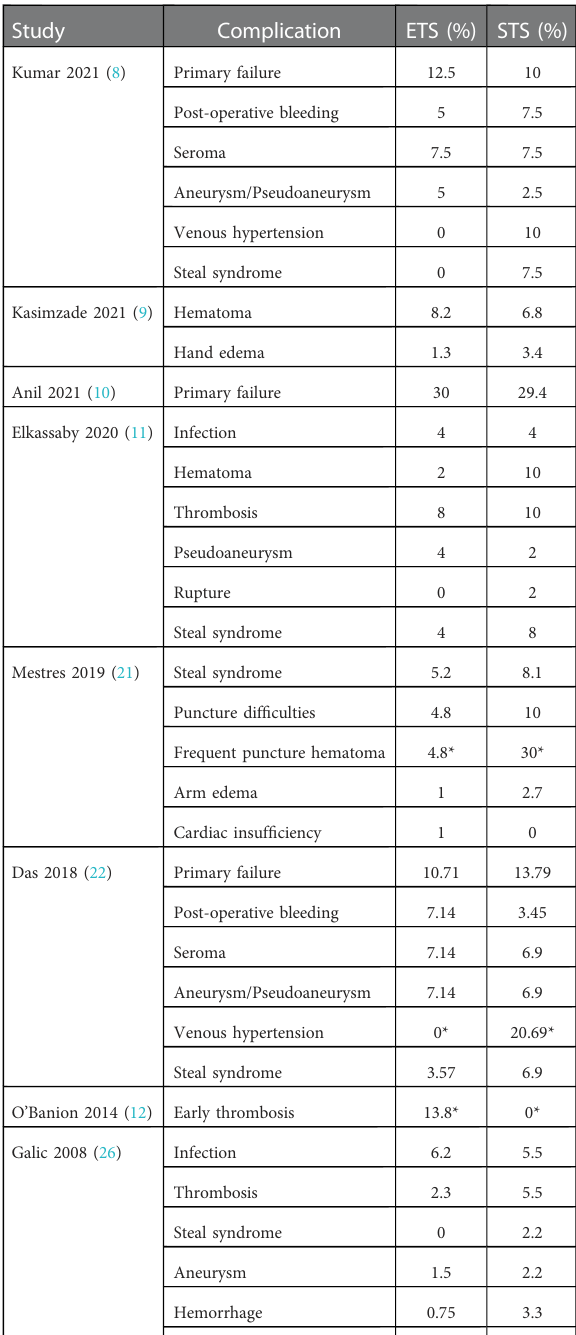
TABLE 3 Complications reported by individual